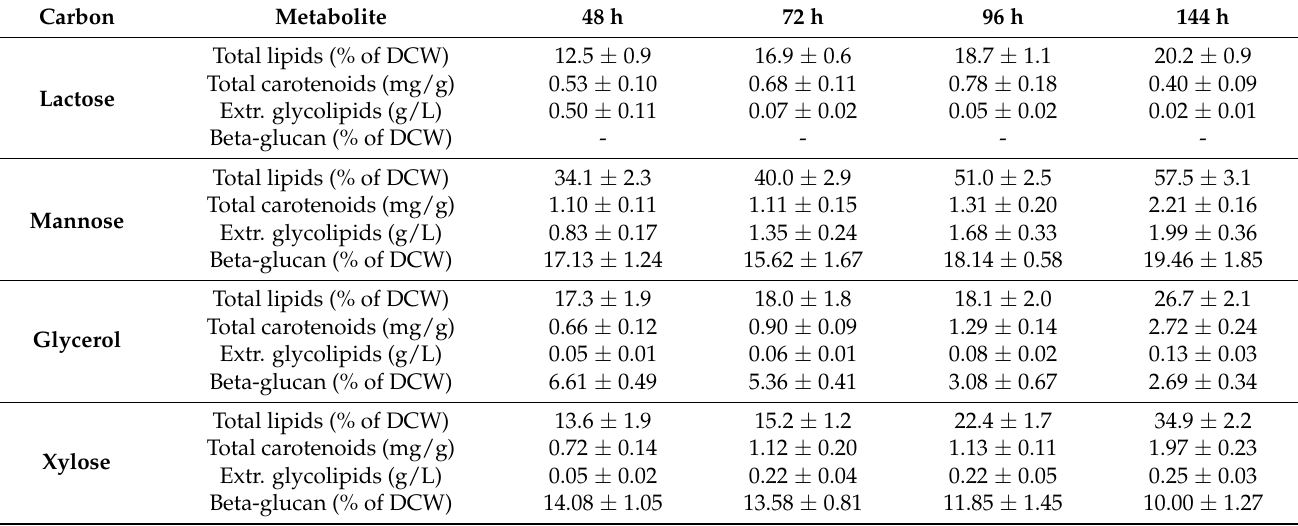
Table 7. Biomass composition of R. kratochvilovae CCY 20-2-26 cultured on different carbon sources with potassium nitrate.